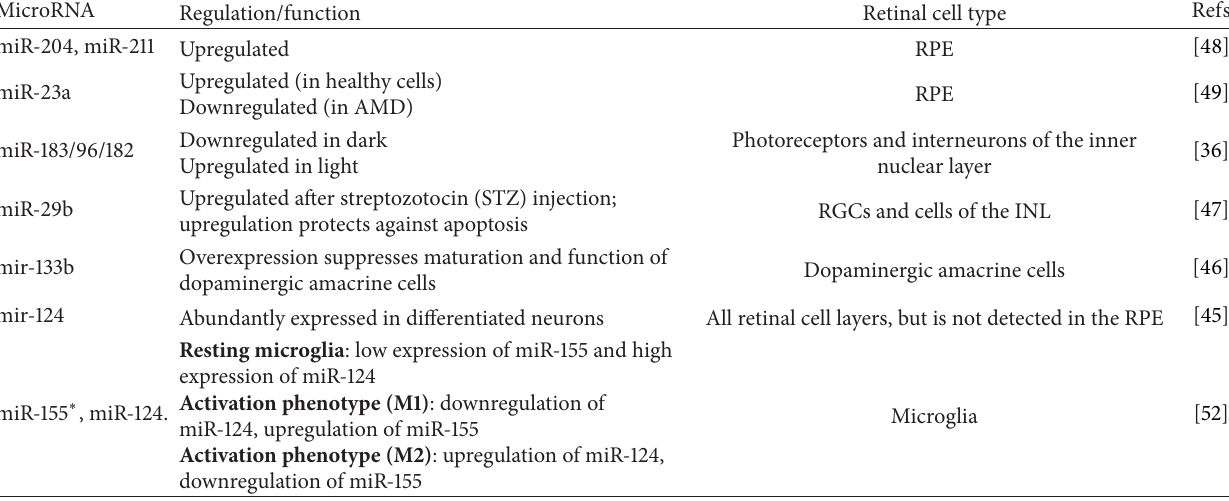
Table 2: Differentially expressed microRNAs in retinal cell types.